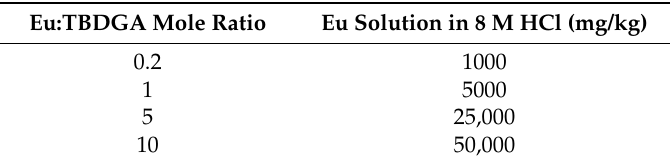
Table 2. Eu solutions, Eu:TBDGA mole ratio.